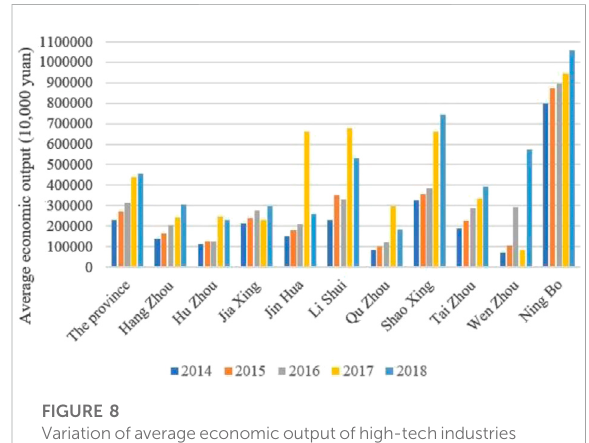
FIGURE 8 Variationofaverageeconomicoutputofhigh-techindustries in Zhejiang province from 2014 to